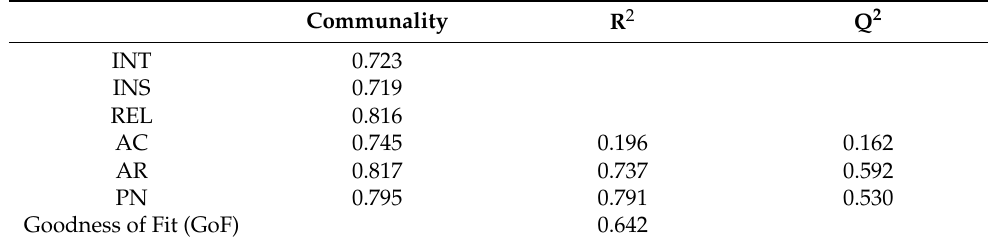
Table 5. Overall model and structural model tests.